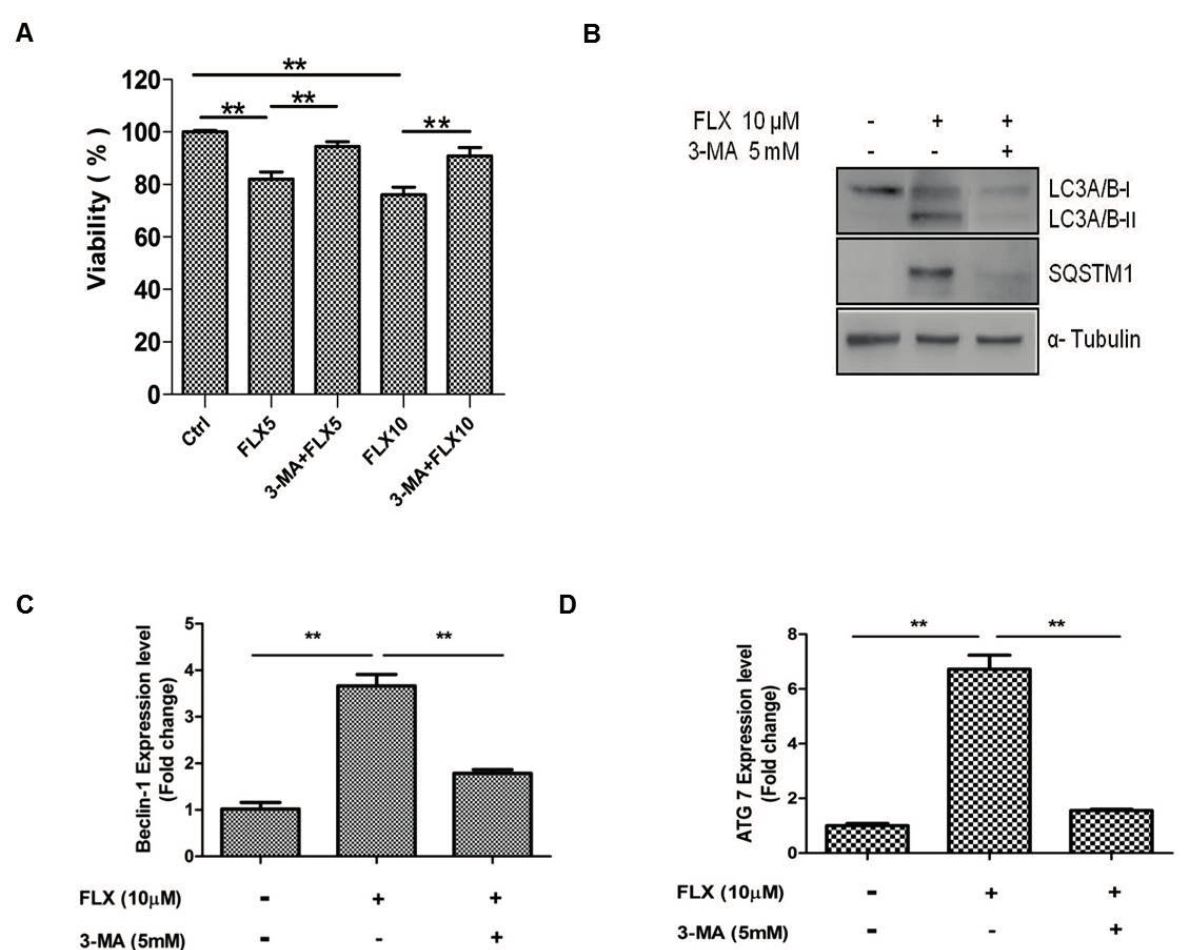
Figure 4. Autophagy inhibition study. ( A ) 3-Methyladenine (3-MA, an autophagy inhibitor) significantly attenuated fluoxetine-induced suppression of ASC viability; ( B ) 3-MA down-regulated the fluoxetine-induced effects on the protein levels of SQSTM1 and LC3B detected by western blotting; ( C , D ) 3-MA significantly down-regulated the mRNA levels of the autophagy-related genes, beclin-1 ( C ) and Atg7 ( D ), detected by quantitative real-time PCR. All values are presented as a mean ± STD ( n = 3). ** p <